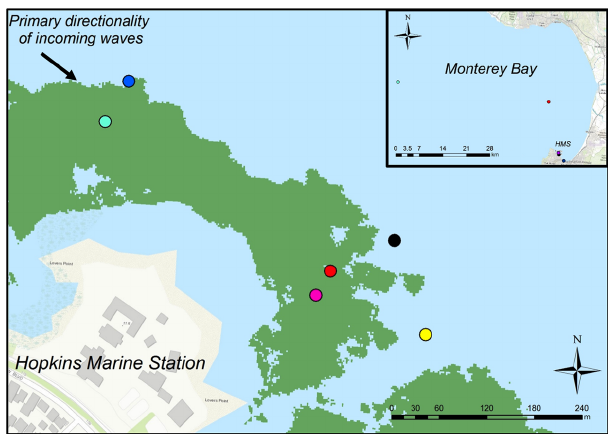
Figure 1. Study site: kelp forest offshore of Hopkins Marine Sta- tion. Green shows historical average kelp canopy extent. Site names are as follows: Protected Offshore (Pro Off; black), Protected Mid- dle (Pro Mid; red), Protected Inside (Pro Inn; magenta), Kelp For- est Array (KFA; yellow), Exposed Offshore (Exp Off; blue), and Exposed Middle (Exp Mid; cyan). Inset shows Monterey Bay with color dots corresponding to the data buoys shown in Fig.